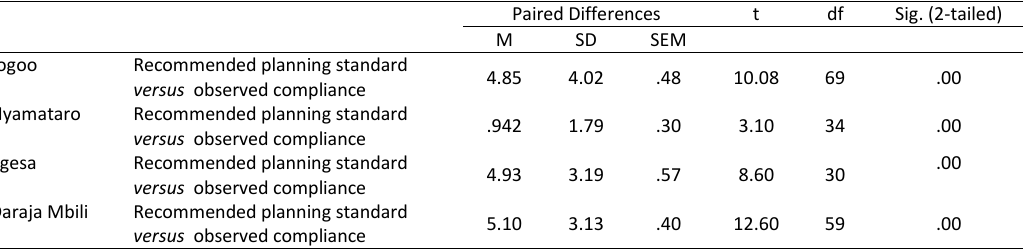
Table 4: Paired sample test - parking, Mwamosioma sub-location